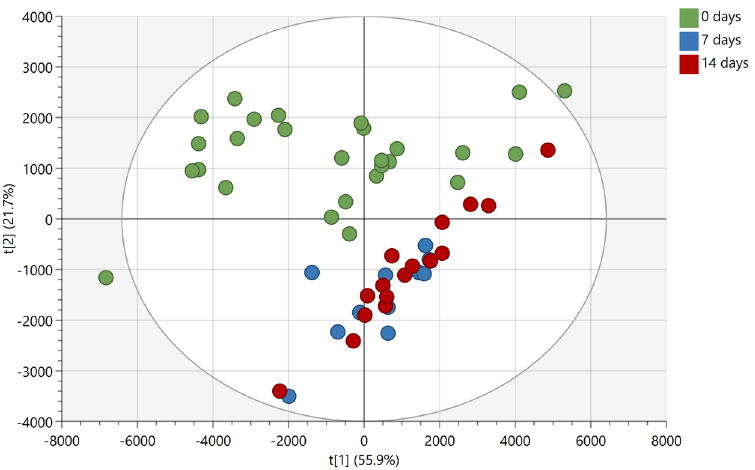
Figure 4. PCA score plot (R 2 X(cum) = 0.906; Q 2 (cum) = 0.815) of 0-, 7-, and 14-days-old